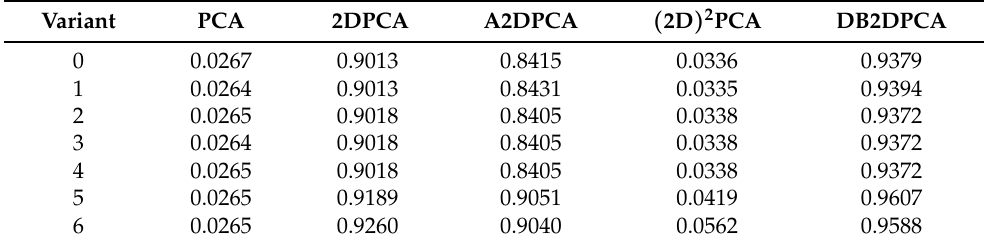
Table 7. The average classification accuracies on the Extended Yale B face database and its six reordered databases with CRC as the classifier when only the first two features are used to per- form